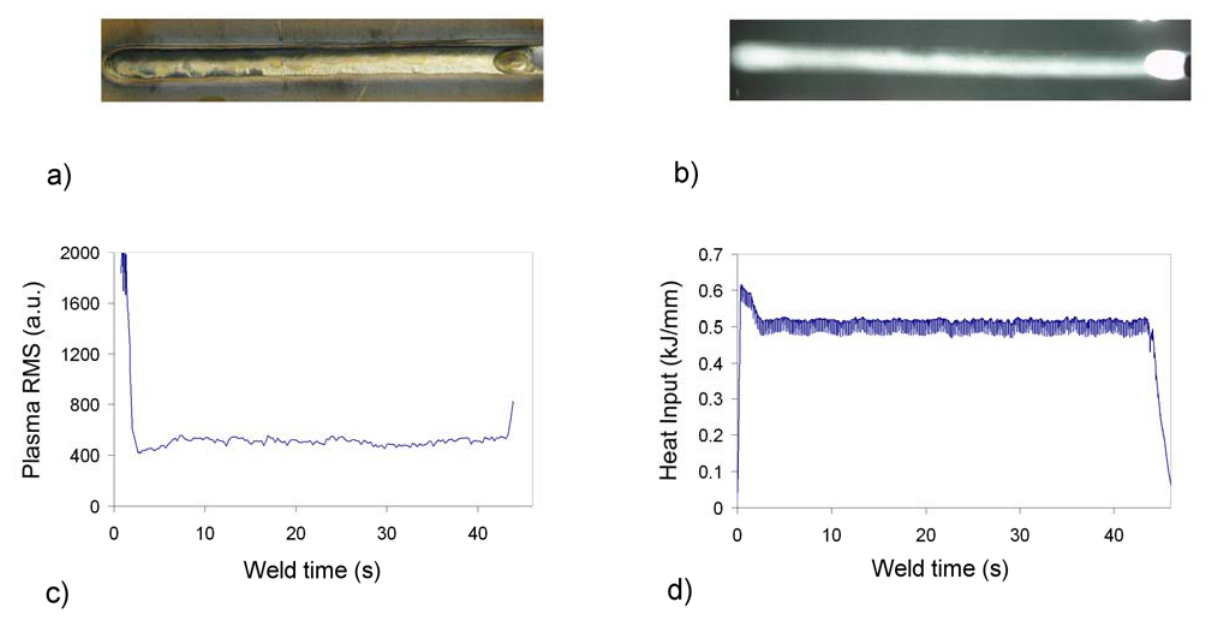
Figure 2. Plasma RMS and heat input profiles for weld test free of defects on Inconel